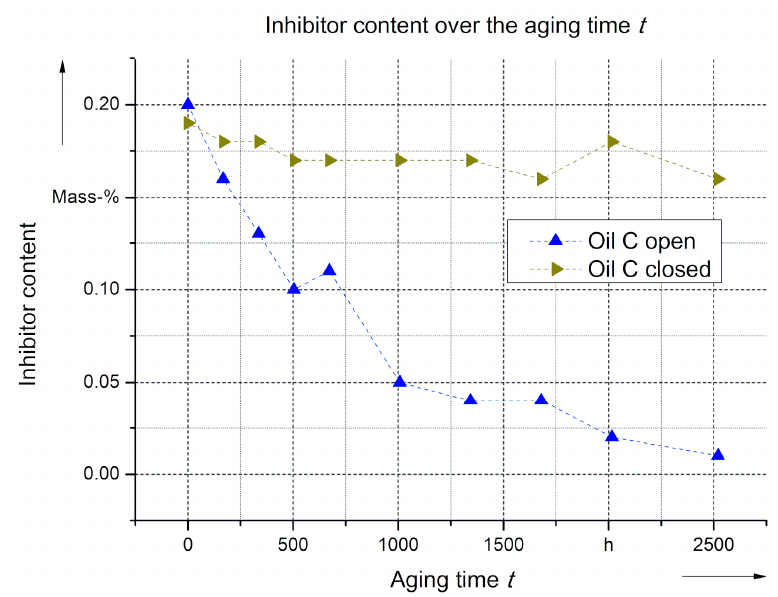
Figure 16. Change in inhibitor content for Oil C as a function of sealing system (open and closed) over aging time t .